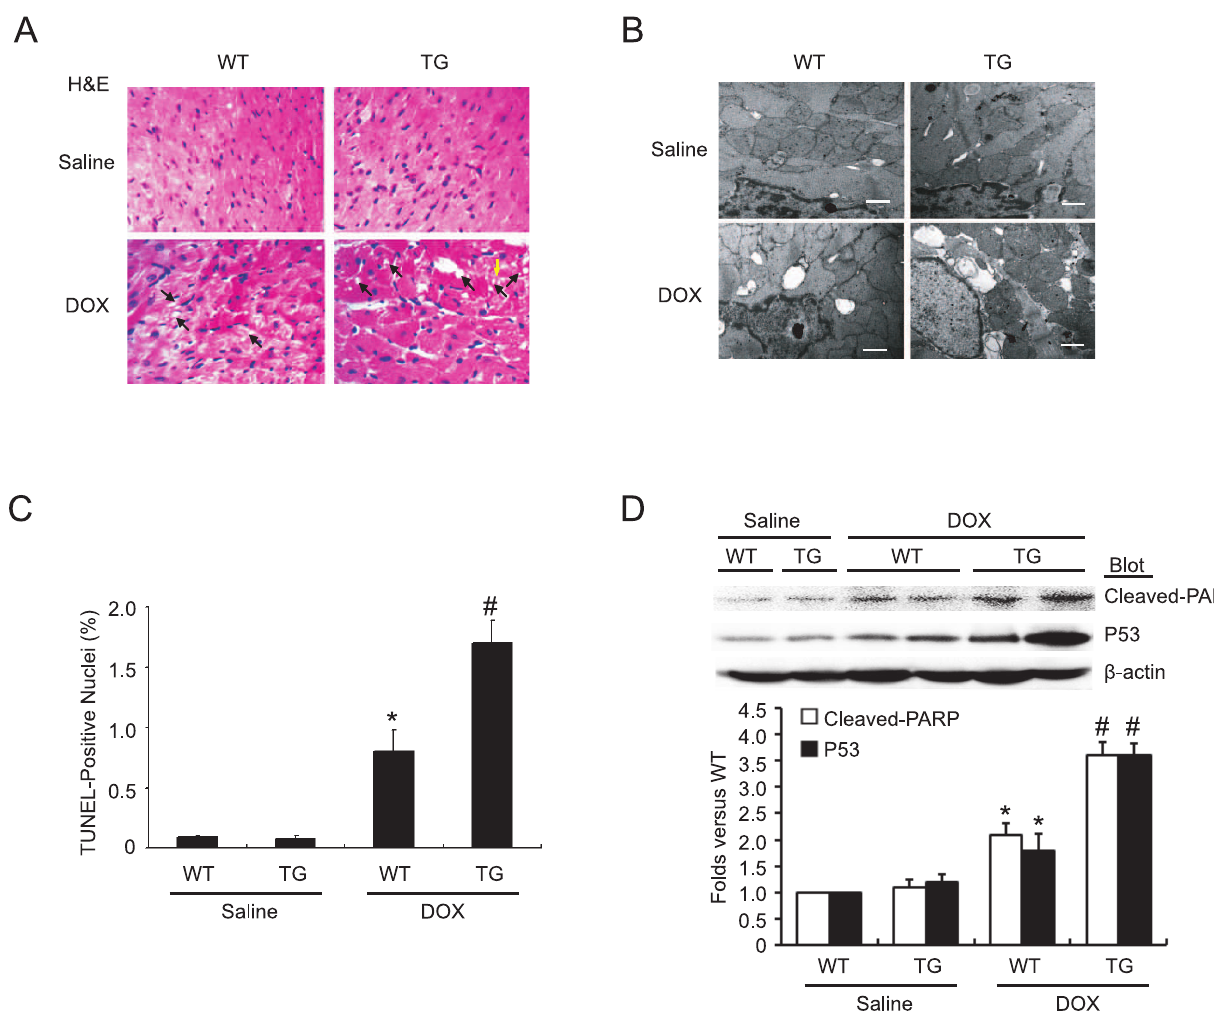
Figure 3. Cardiac-specific overexpression of Nrdp1 aggravates DOX-induced cardiac injury and cardiomyocyte apoptosis. A. H&E staining of heart sections on day 5 after saline or DOX treatment (n=4 per group). Arrows indicate representative vacuolization. Magnification 6 200. B. Representative electron microphotographs of cardiac sections from wild type (WT) (left panel) and Nrdp1 transgenic (TG) mice (right panel) treated with saline or 20 mg/kg DOX for 4 days (n=3 per group). Arrows indicate cytoplasmic vacuolization. Scale bars=1 m m. C. Quantitative results of cardiomyocyte apoptosis detected by TUNEL assay (n=4 per group). D. Western blot analysis of protein level of cleaved PARP and p53 in WT and Nrdp1 TG mice treated with saline or DOX (n=5 per group). Quantitative analysis is in the bottom panels. * P , 0.01 vs WT + saline mice; # P , 0.01 vs WT + DOX mice.